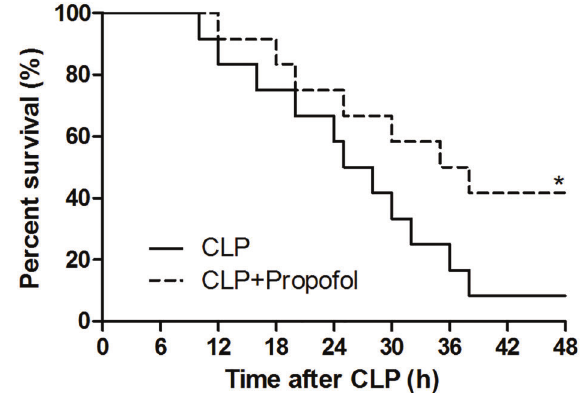
Figure 2. Propofol improved survival outcome in septic mice. Kaplan-Meier survival curves of cecal ligation and puncture (CLP)- operated mice treated or non-treated with propofol. Data are reported as means ± SD (n=12 per group). *P o 0.05 compared with the CLP group (log-rank